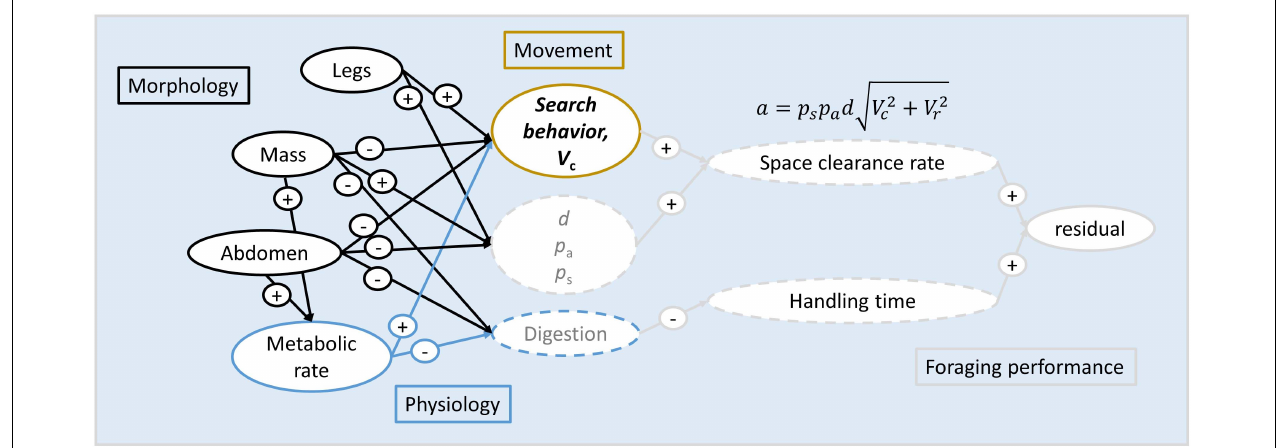
FIGURE 1 | Conceptual map of linkages between morphological and physiological traits, movement, foraging mechanisms, functional response parameters, and residual foraging performance. Specifically, morphology (leg length, body mass, and abdomen width, all outlined in black) are expected to influence movements and the ability to detect, capture, and digest prey, thus impacting the mechanistic components of both space clearance rate (functional response parameter a ) and handling time (functional response parameter h ) in several ways. For example, long legs may increase velocity, as shown with the plus (+) sign. Physiology, such as metabolic rate (outlined in blue), should shorten digestion time (–) and increase power output (+), thus altering movement. Movement (outlined in gold) should then alter space clearance rate through effects on velocity and thus encounters. The mathematical breakdown of space clearance rate (Eq. 2 in the main text) shows how the probabilities of attack and success, detection distance, and velocity influence the functional response, thereby creating a mechanistic link between traits and foraging performance. In this study, we measured average space clearance rate and handling times, and evaluated the links between individual traits of morphology, physiology, and movement and residual foraging performance to identify the sources of intra-specific variation in functional responses. Solid outlines refer to traits we measured at the individual level, and dashed outlines refer to traits that we could not measure at the individual level. Traits written in black are measured; those in gray are traits we did not